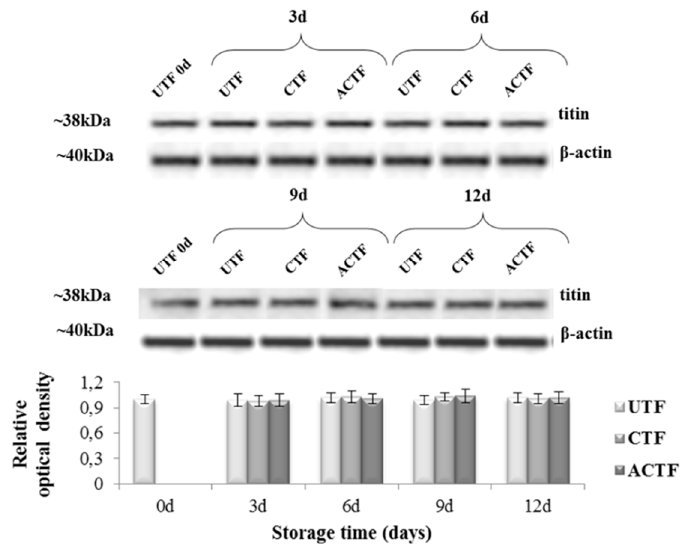
Figure 3. Western blotting of titin. Analysis was carried out on the control and coated fillets (UTF = uncoated fillets; CTF = coated trout fillets; ACTF = active coated trout fillets; d = day) during the storage time (0, 3, 6, 9, and 12 days). β -actin was used as an internal marker. Results are representative of three trout analyzed for each experimental group.